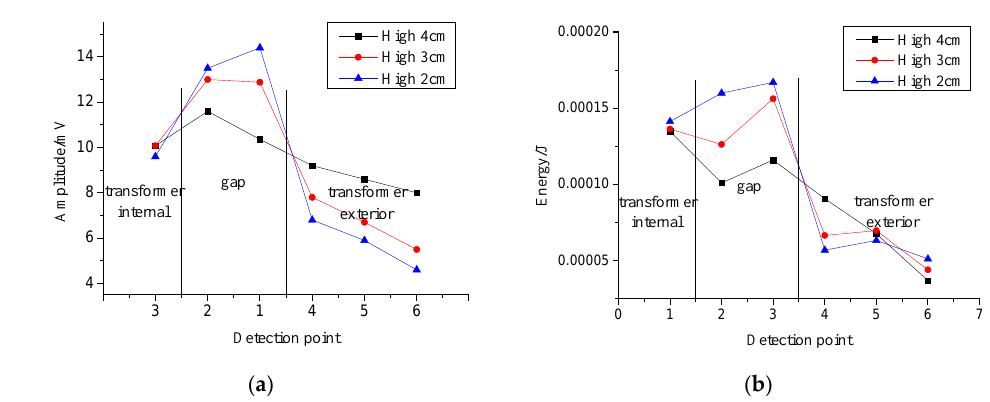
Figure 18. Distributions of PD electromagnetic signals in different height gaps in experiment: ( a ) Amplitude distribution; ( b ) Cumulative energy distribution.